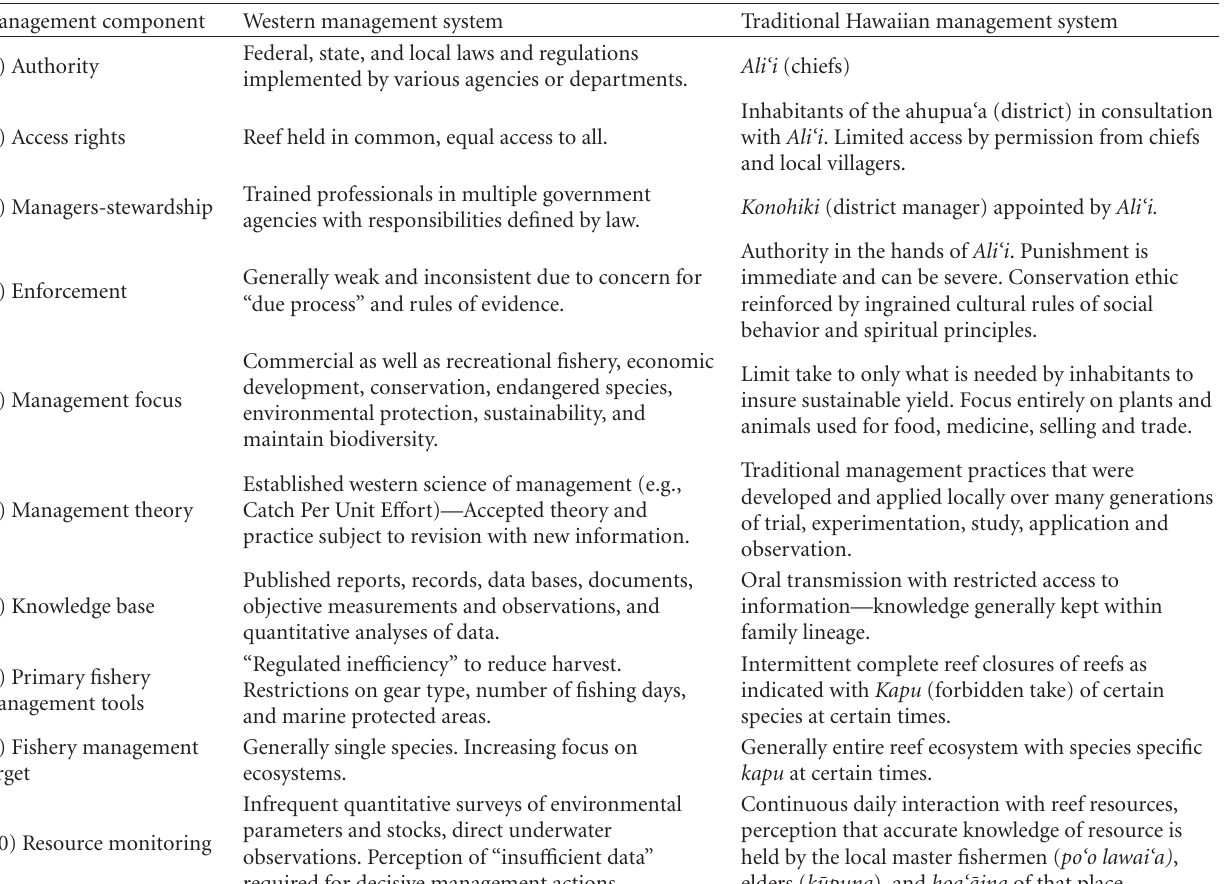
Table 1: Comparisons between major aspects of “Traditional Hawaiian” and “Western” management systems in Hawai‘i for inshore reef